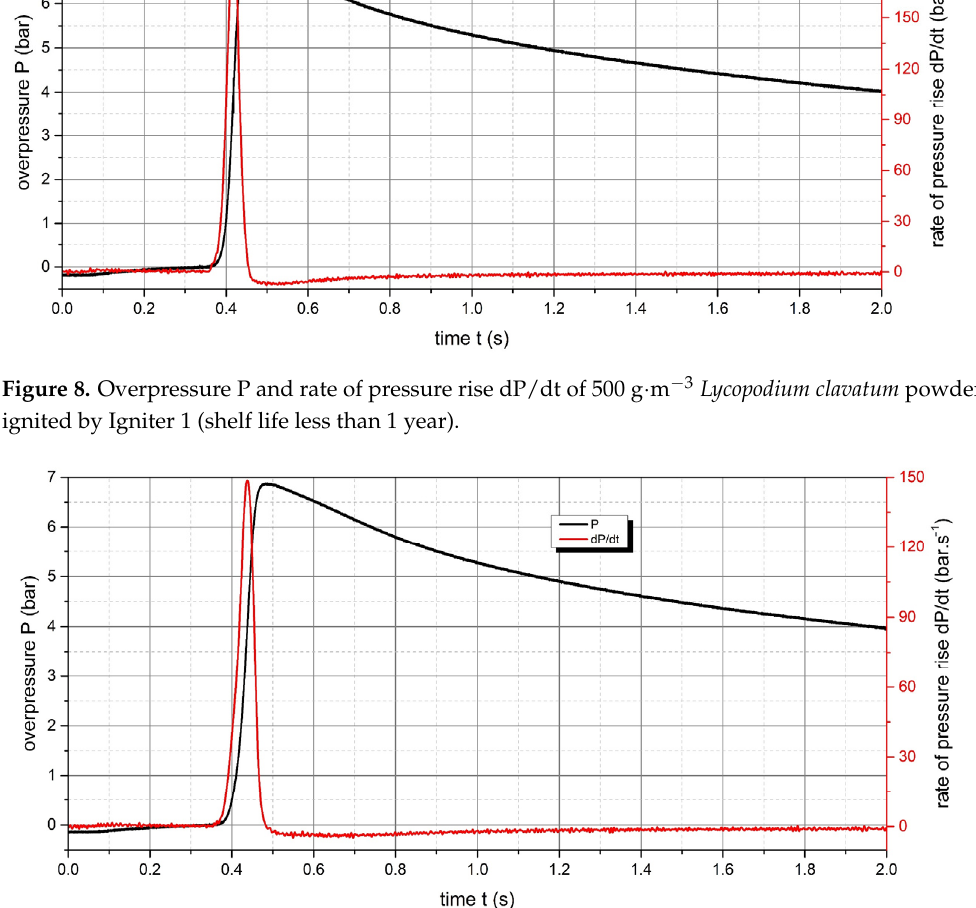
Figure 9. Overpressure P and rate of pressure rise dP/dt of 500 g · m − 3 Lycopodium clavatum powder ignited by Igniter 2 (shelf life 2